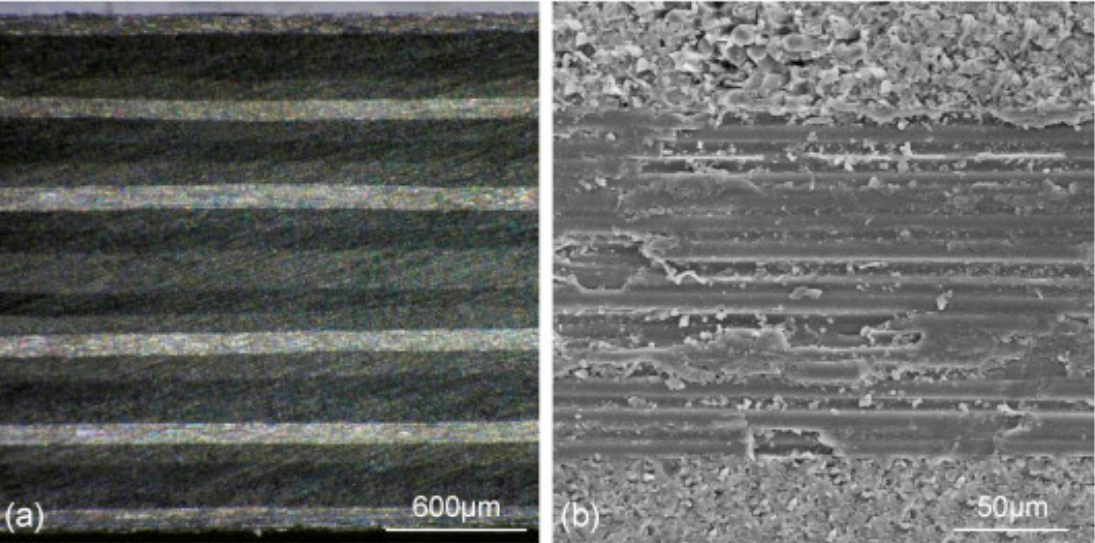
Figure 1. Cross section of CFRP composites at two magnifications ( a ) 20 times; ( b ) 400 times.